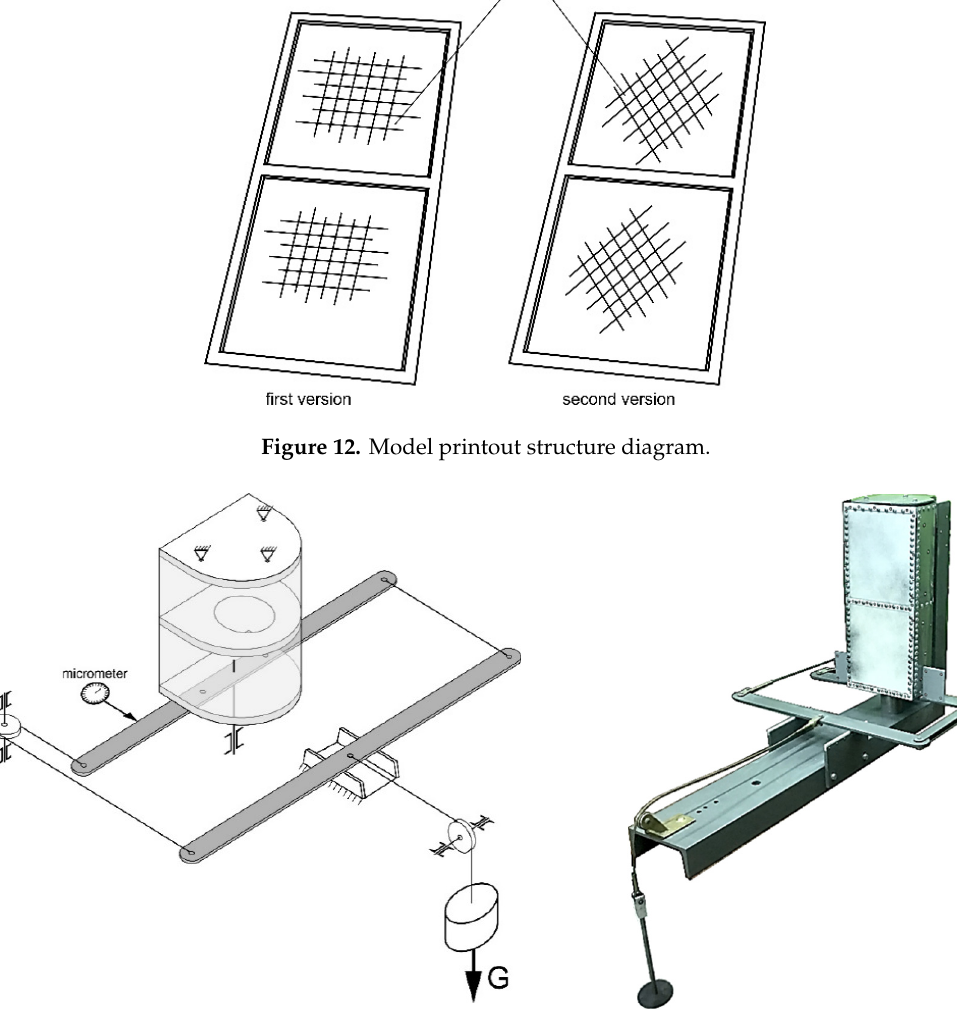
Figure 13. Scheme and general view of the test stand with the mounted model.